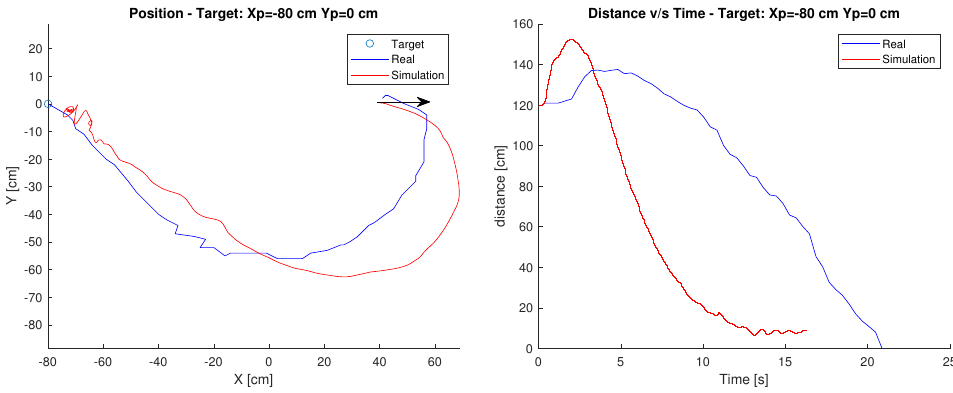
Figure 9. Position and distance to target X p = − 80 cm, Y p = 0 cm with the Villela